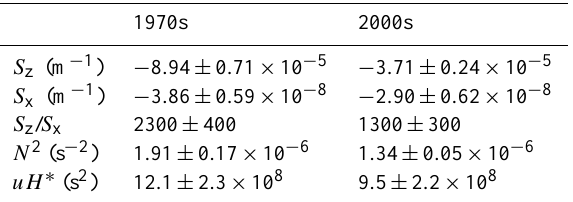
Table 3. Mean vertical salinity gradients, horizontal salinity gra- dients, their ratios, N 2 and uH ∗ for the RSBW in the 1970s and 2000s from region between 150km and 900km downstream from the Drygalski